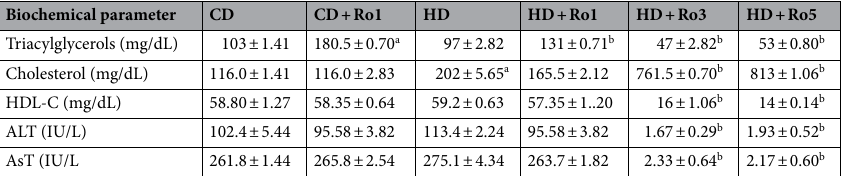
Table 1. Effect of Rosuvastatin (20 mg/kg/day) in cholesterol, triacylglycerols, HDL-C, and transaminases in serum of mice. Triacylglycerols, cholesterol, HDH-C serum level, aspartate aminotransferase (AST), and alanine aminotransferase (ALT), Ro (Rosuvastatin). Values represent the mean ± SEM of eight animals. Statistical analysis was done by One ANOVA, followed by the Student-Newman–Keuls test. Key of significance: a compared with CD and b with HD ( p < 0.05).